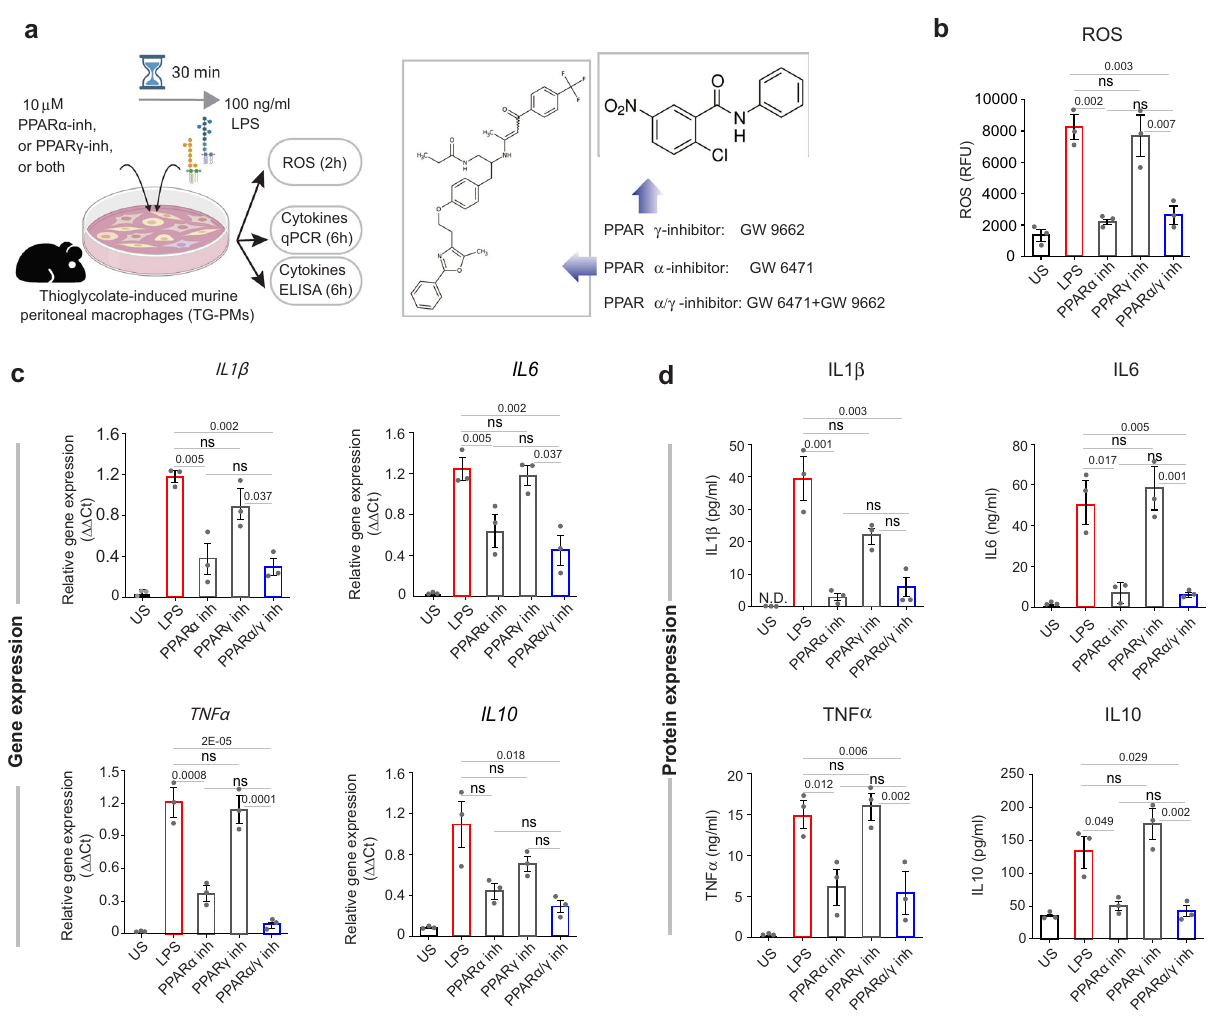
Fig. 6 PPAR α but not PPAR γ is required for induction of cellular ROS and proin fl ammatory cytokines. a Schematic of experimental design. TG-PMs were pre-incubated with 10 μ M PPAR α or PPAR γ inhibitors (illustrated on the right), either alone or in combination for 30 min prior to stimulation with 100 ng/ml LPS. Cells were analyzed at 2 and 6 h to estimate cellular ROS and cytokine induction, respectively. b – d Bar graphs display the levels of cellular ROS ( b ), relative levels of mRNA (the target genes were normalized to 18S rRNA gene and the fold change in the mRNA expression was determined using the 2 − ΔΔ Ct method) ( c ) and protein ( d ) expression of cytokines (IL1 β , IL6, TNF α , and IL10). Statistics: Results are from three independent experiments and displayed as mean ± SEM. One-way ANOVA followed by Tukey ’ s test for multiple comparisons was performed to test signi fi cance. Signi fi cance: n.s, not signi fi cant, p -value < 0.05 was considered signi fi